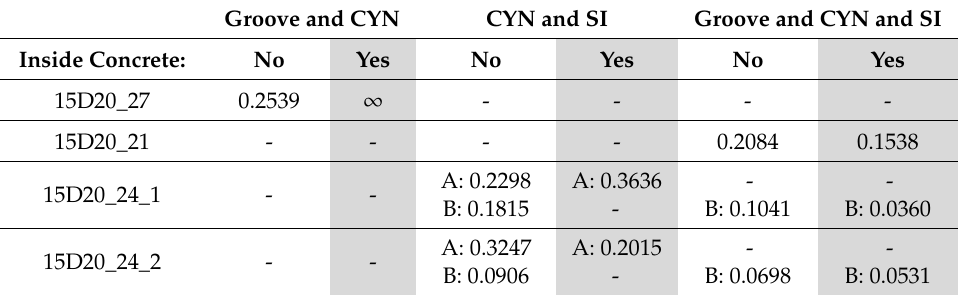
Table 1. Slope coe ffi cient of the average strain reading noise growth with load for the presented RC ties and subdivided per bonding technology and presence / absence of concrete.